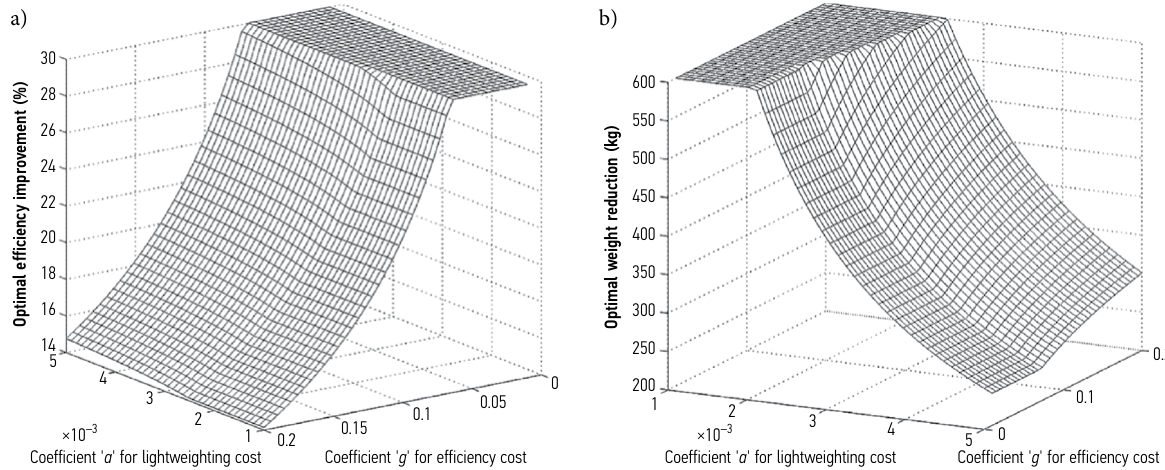
Fig. 11. Optimal efficiency and lightweighting technology implementation at various exponential cost levels